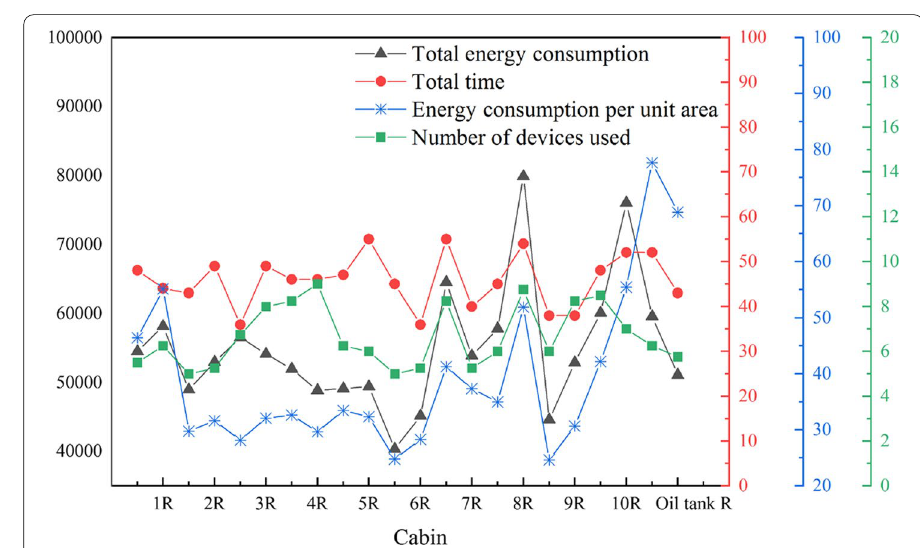
Fig. 2 Evaluation index values of each